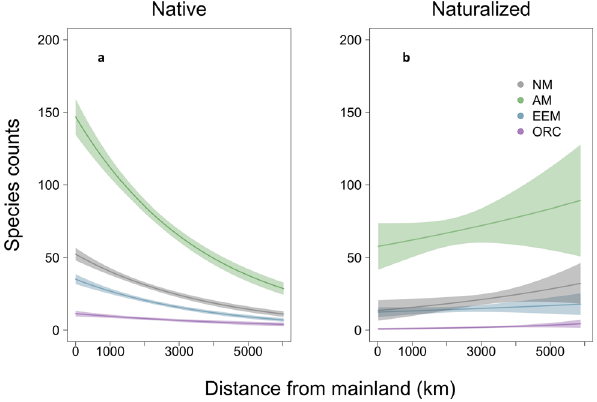
Fig. 3 Distance patterns across mycorrhizal types in native and naturalized oceanic island fl oras. The proportion of AM:NM plants in the native island fl ora decreases with oceanic island distance from the mainland ( a estimate = − 0.034 ± − 0.006, p < 0.01, n = 325; GLM), consistent with AM plants being differentially limited in colonization of far islands. In contrast, no patterns with distance are detectable in naturalized oceanic island fl oras ( b estimate = 0.034 ± 0.005, p = 0.25, n = 105; GLM). Con fi dence intervals represent 95% con fi dence Table 3a M1; and ORC:NM p < 0.001, supplementary table 6a M1), consistent with the establishment limitation for orchids on islands. However, the proportion of orchid species increased with greater distance from the mainland as compared to both other mycorrhizal ( p < 0.001, Supplementary Table 3a M4) as well as NM plant species ( p < 0.01, Supplementary Table 6a M4), suggesting lower dispersal limitation.